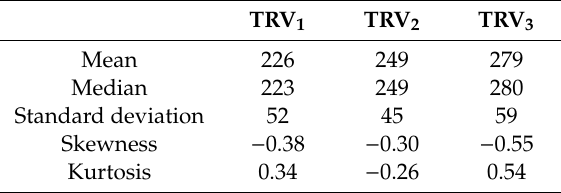
Table 2. Statistical output of the dataset from the three di ff erent methods for calculating tree row volume (TRV; m 3